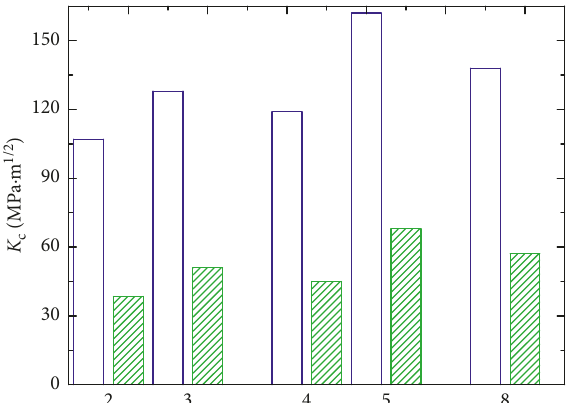
Figure 5: Fracture toughness of specimens of the 05Cr19Ni55 alloy of 20mm thickness after open and vacuum arc melting in air (light bars) and in hydrogen under pressure 30MPa after hydrogenation (shaded bars). The numbers near curves correspond to ordinal numbers